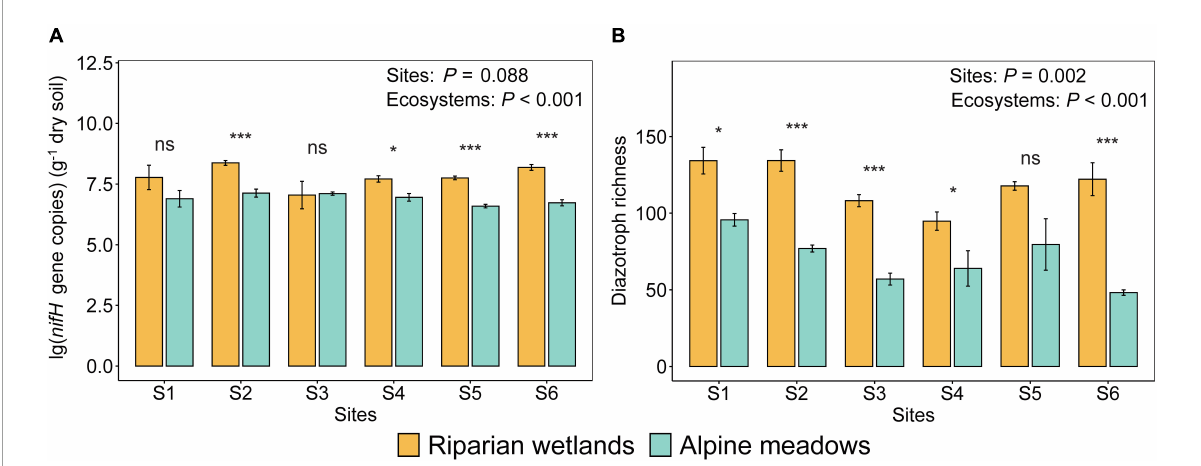
FIGURE1 The differences in the diazotrophic abundance (A) and richness (B) between the riparian wetland and alpine meadow soils. All the data were presented as mean ± SE [Sites: The effects of sites; ecosystems: The effects of ecosystem types (i.e., alpine meadows and riparian wetlands); Asterisks indicate the significance of the ANOVA results (* P < 0.05; *** P < 0.001; ns: no